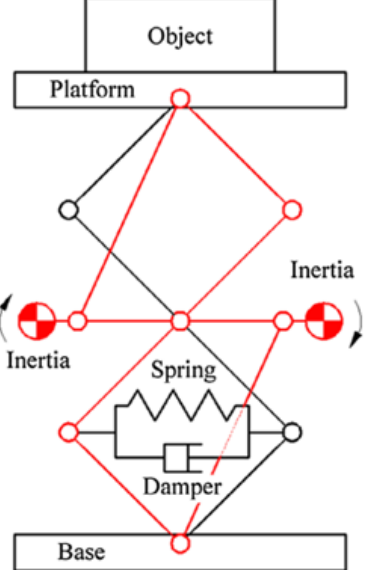
Figure 15. Motion ( a ) and simplified model ( b ) of hand and leg when walking [69].